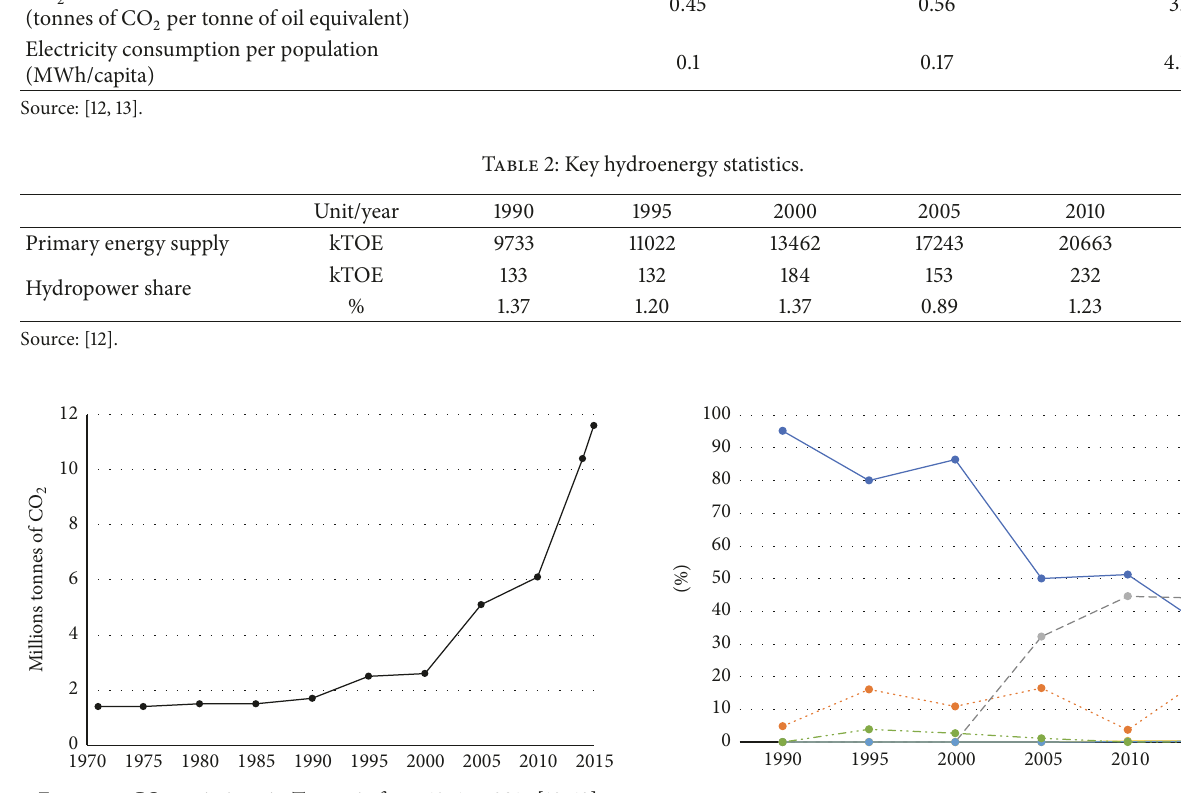
Figure 5: CO 2 emissions in Tanzania from 1971 to 2015 [12, 13].